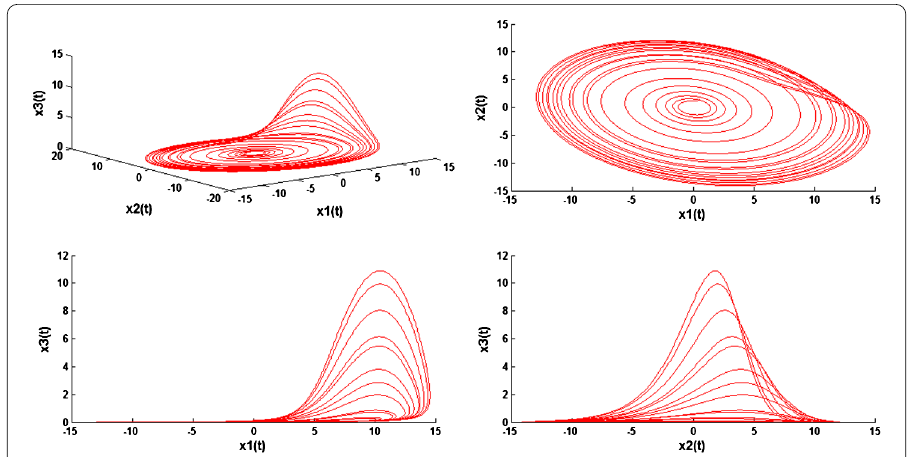
Figure 1 Different plots of the chaotic attractor of the commensurate fractional Rössler system (19).